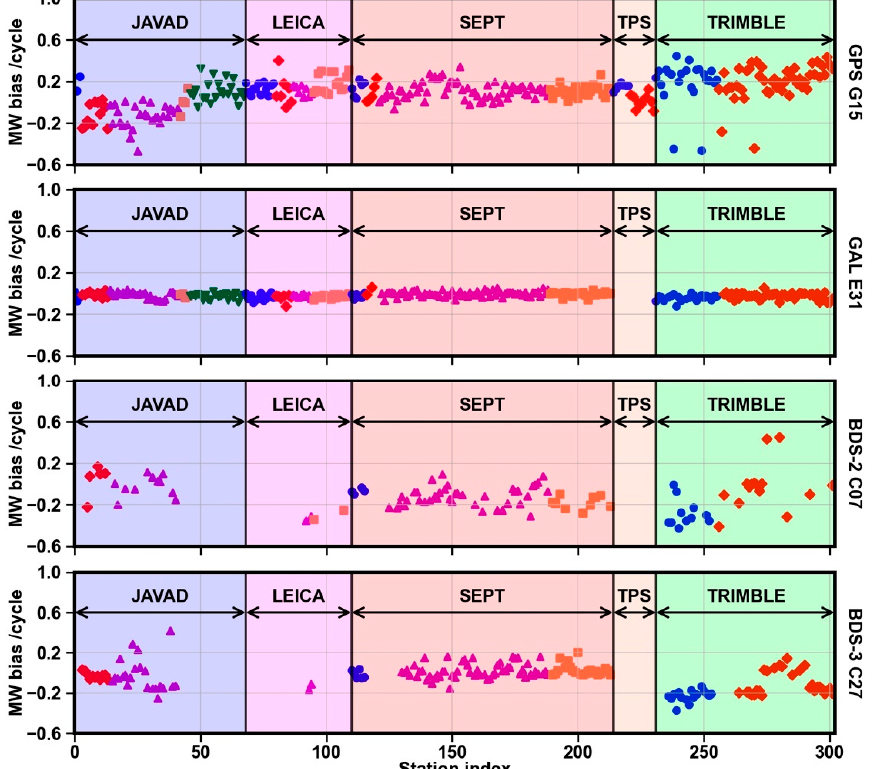
Figure 2. Average receiver-related MW SDBs from DOY 45 to 51, 2021. Table 3. Details of the data processing strategies.